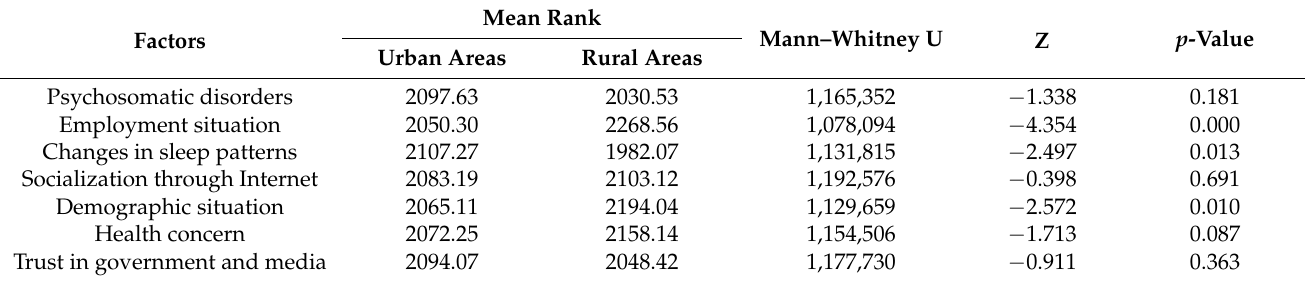
Table 4. Differences between urban and rural residents.